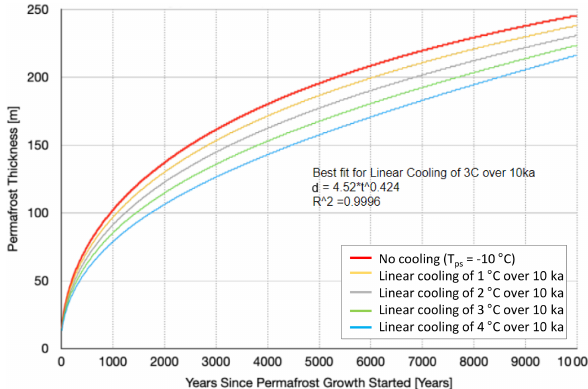
Figure 13. Results from 1D numerical (finite-difference) model solving the classical Stefan problem of vertical heat diffusion cou- pled with latent heat release during freezing. The plot shows how age of permafrost increases with increasing permafrost thickness for various linear cooling trends to simulate lowering temperatures in the Holocene. The equation shown above shows the best fit line for an applied linear cooling rate of 3 ◦ C over 10000 years (green line; Eq.